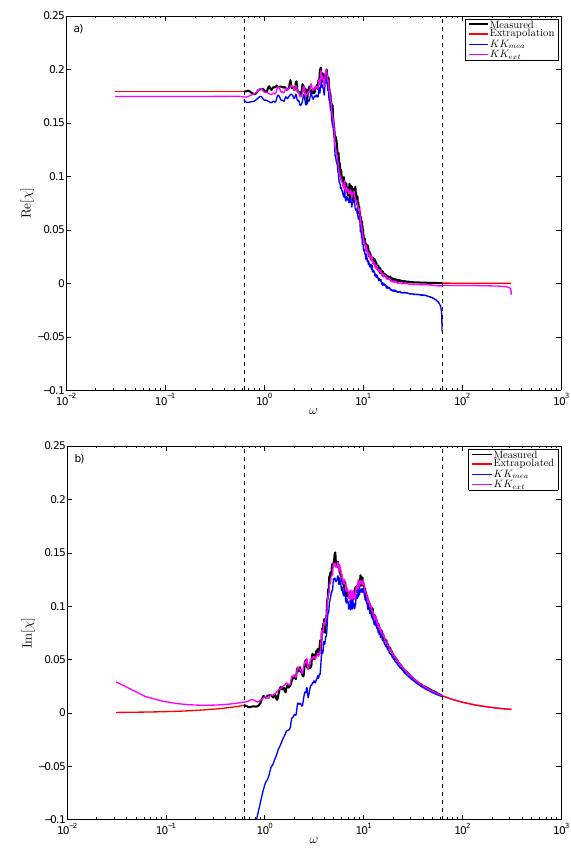
Fig. 7. Linear susceptibility of the momentum at the grid point where the local perturbation is applied. The real and the imaginary parts are depicted in (a) and (b) , respectively. The measured and extrapolated values are shown in red and black lines, respectively. The result of the Kramers-Kronig inversion done with the measured and with with the extrapolated data are shown in blue and magenta lines,